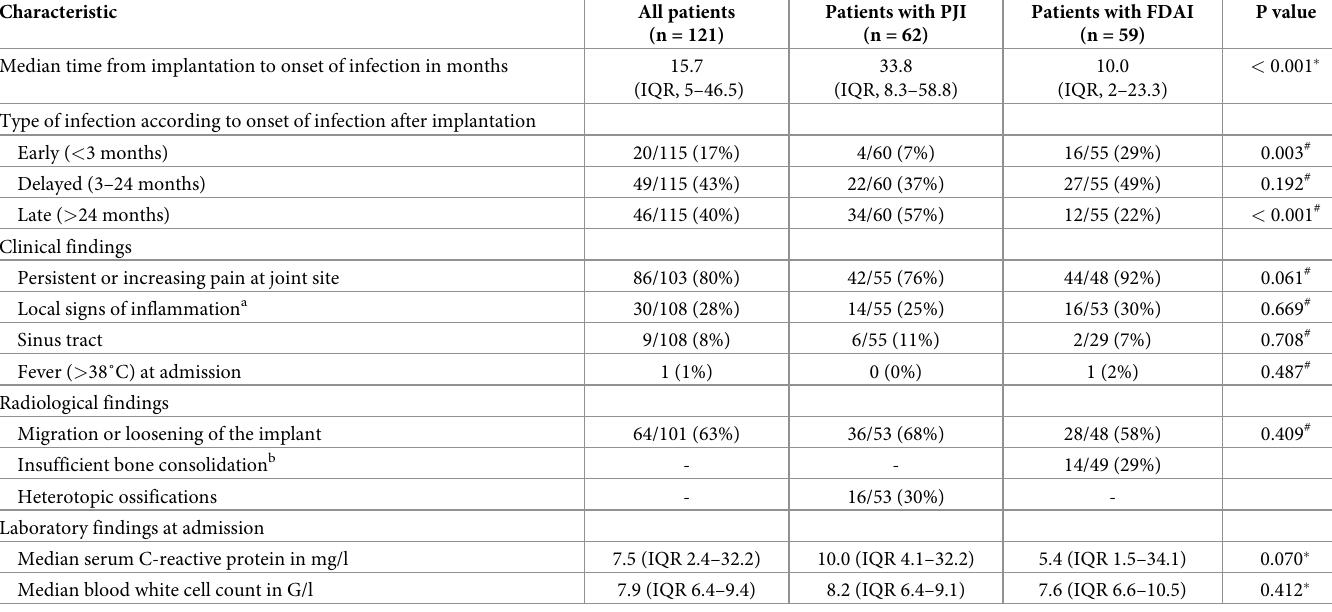
Table 2. Infection characteristics of 121 orthopedic implant-associated infections, including 62 with periprosthetic joint infections (PJI) and 59 with fixation device-associated infection (FDAI). Characteristic